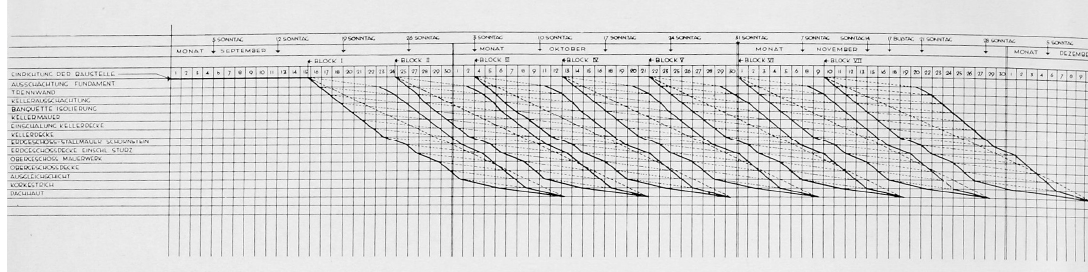
Figure 18. Walter Gropius: Dessu-Törten Housing, 1926–1928—“Work graph” (‘Arbeitsgraphikon’). Image taken from (Gropius 1930, p. 172).